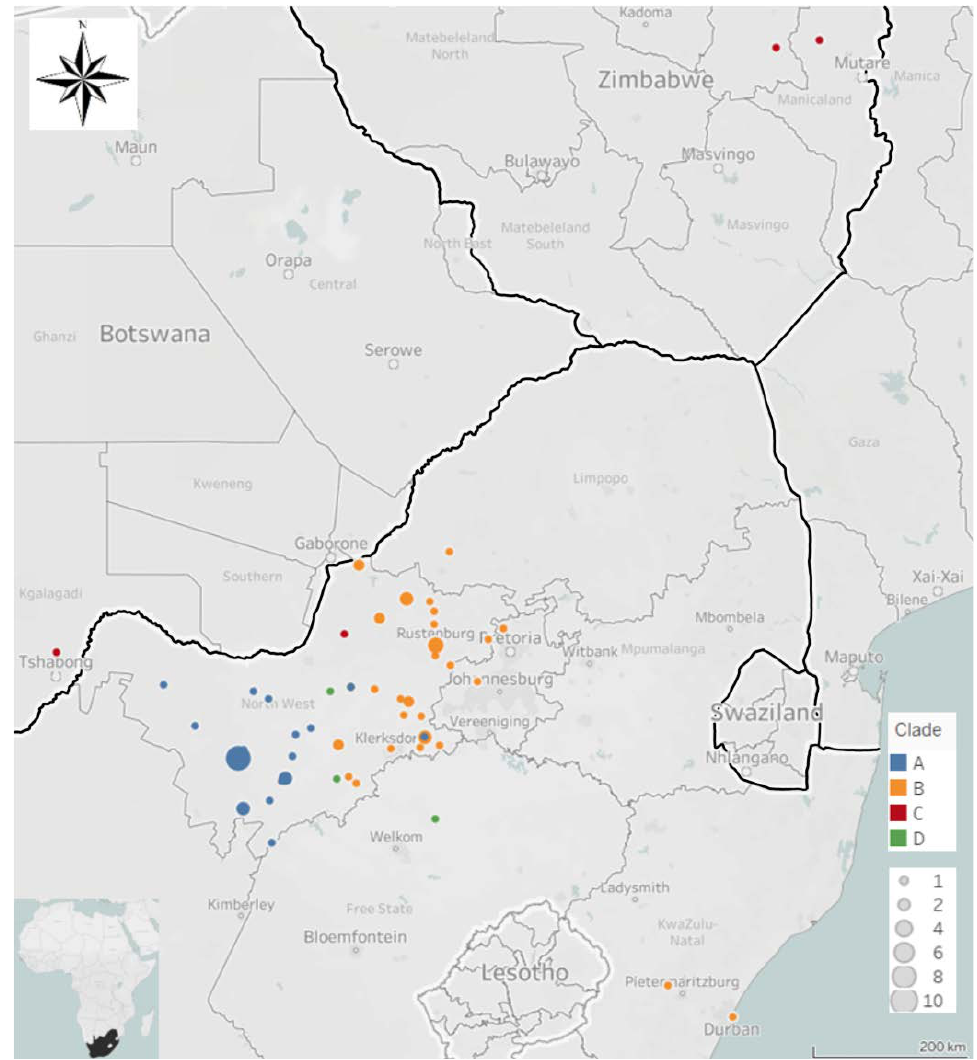
Figure 2. Geographic distribution for RABV sequences from each clade as seen in the phylogenetic analysis for the partial N gene and G-L intergenic region